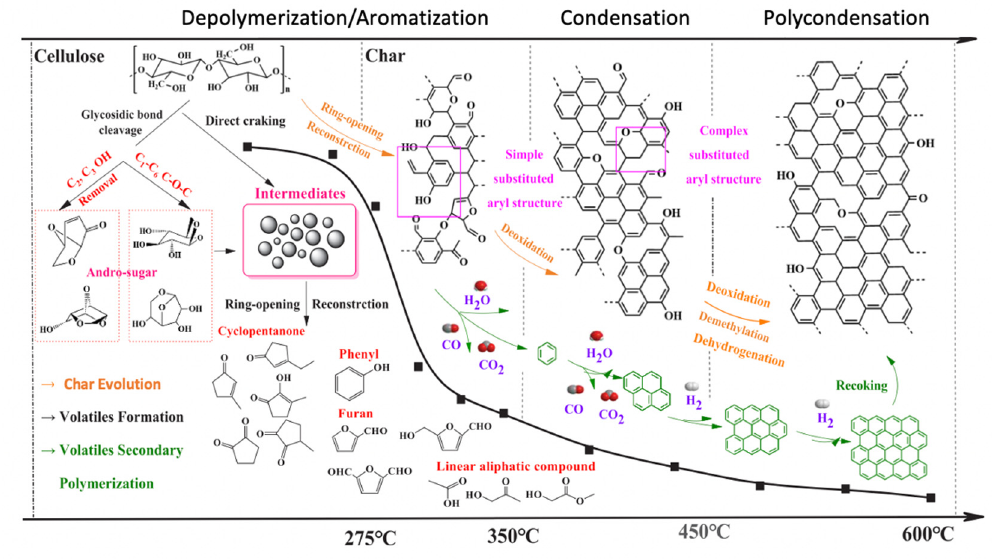
Figure 8. Schematic diagram of cellulose pyrolysis mechanism (readapted with permission from [60]).